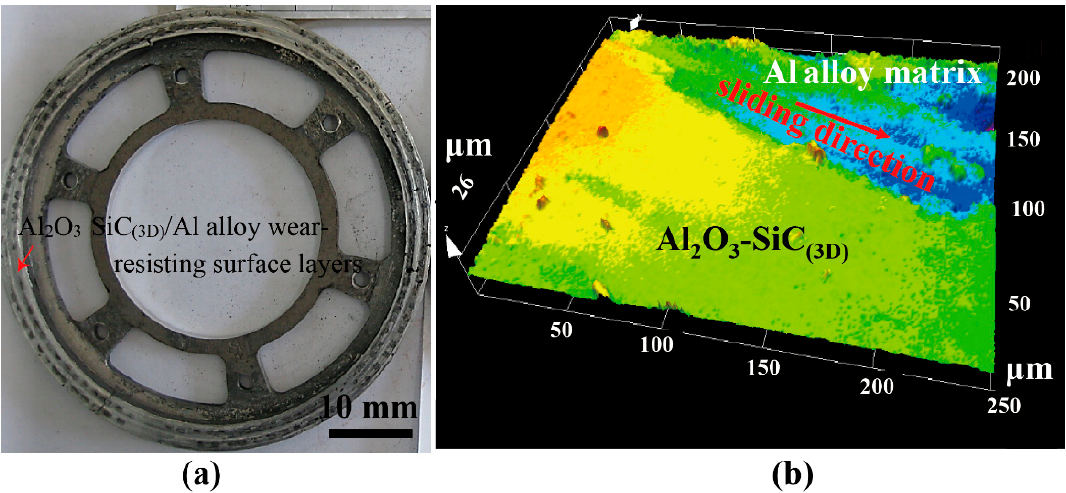
Figure 20. Worn surface of the brake ring after testing at IBV = 97 m/s and pressure 0.80 MPa: ( a ) macrostructures of the brake ring; ( b ) worn surface tested by laser scanning confocal microscope. The cracks of the brake disc caused by the periodic thermal stress are along the radial directions.